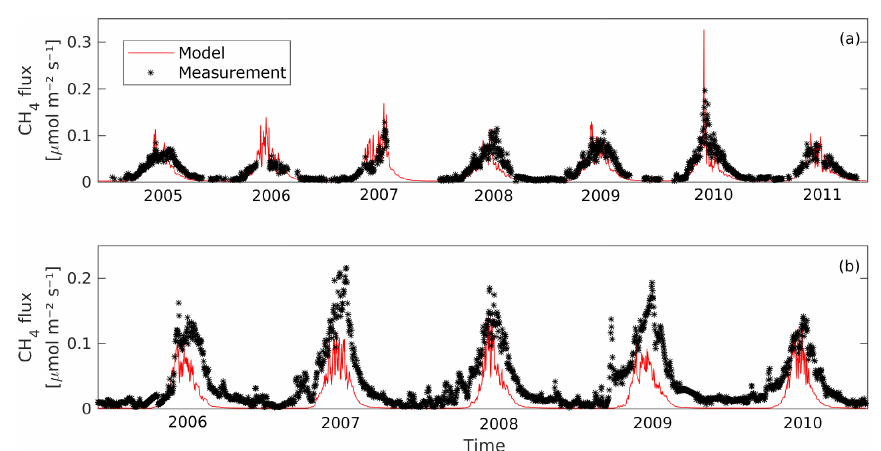
Figure 14. Comparison of simulated and measured CH 4 emissions (a) at Siikaneva and (b) at Lompolojänkkä. The simulations used the logarithmic layer structure and 2m of